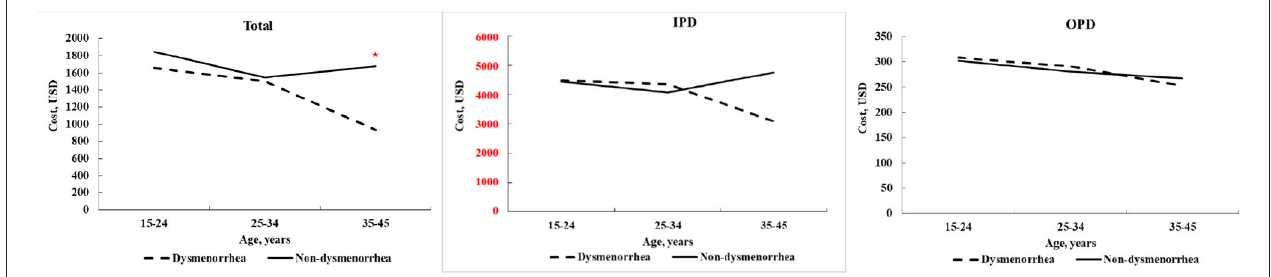
FIGURE 2 | Average costs of stroke care estimated within 30 days post stroke compared by age between women with and without dysmenorrhea.